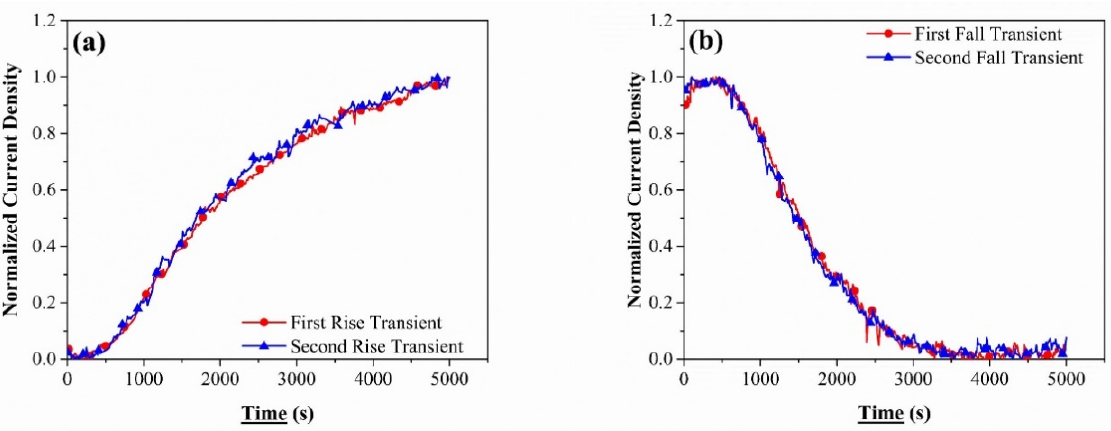
Figure 4. The normalized curve for two successive ( a ) rise transients for CP1000 steel when the charging current density was raised from − 10 mA/cm 2 to − 20 mA/cm 2 and ( b ) fall transients for CP1000 steel when the charging current density was lowered from − 20 mA/cm 2 to − 10 mA/cm 2 .